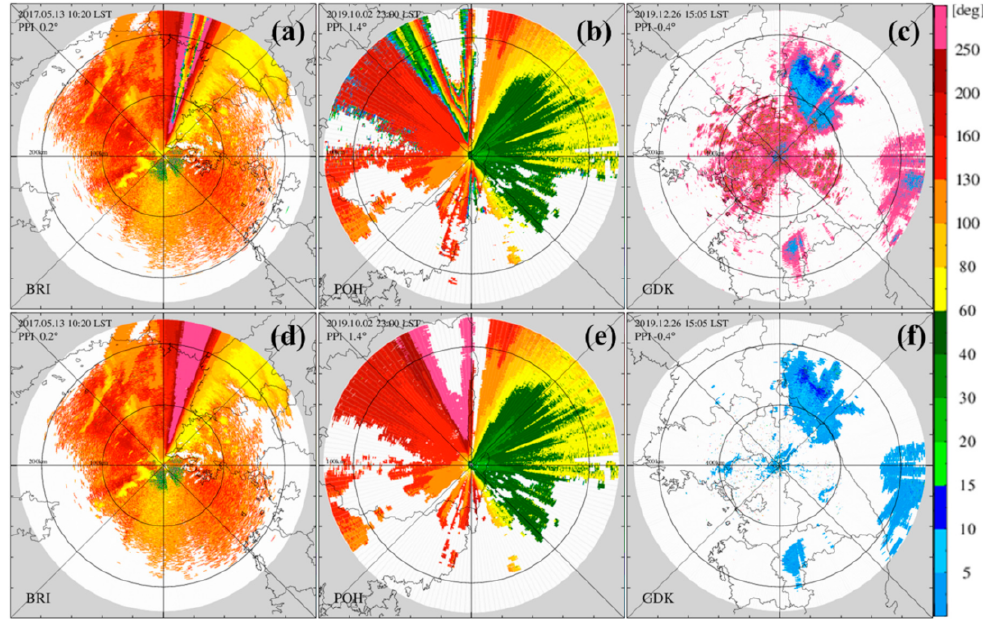
Figure 5. Di ff erential phase ( a – c ) before and ( d – f ) after unfolding for three-folding cases; single folding in S-band BRI radar at an elevation angle of 0.2 ◦ at 1020 LST 13 May 2017 (left), multi-folding in C-band radar at an elevation angle of 1.4 ◦ at 2300 LST 2 October 2019 (middle) in precipitation cases and inverse folding by near-zero o ff set in the S-band GDK radar at an elevation angle of − 0.4 ◦ at 1505 LST 26 December 2019